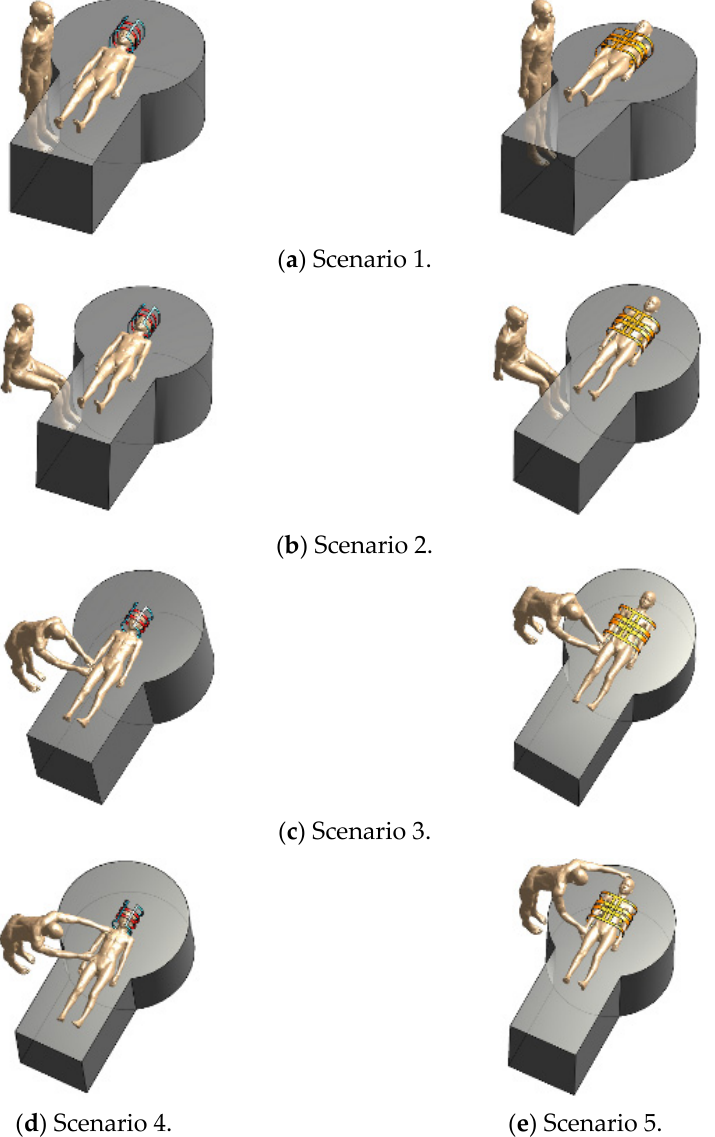
Figure 5. Assessment scenarios of RF energy exposure: The patient assistant ( a ) stands next to the patient (scenario 1), ( b ) sits by the patient (scenario 2), ( c ) holds the patient’s hand (scenario 3), ( d ) holds the patient’s hand and chest (head coil case, scenario 4), and ( e ) holds the patient’s hand and head (body coil case, scenario 5).